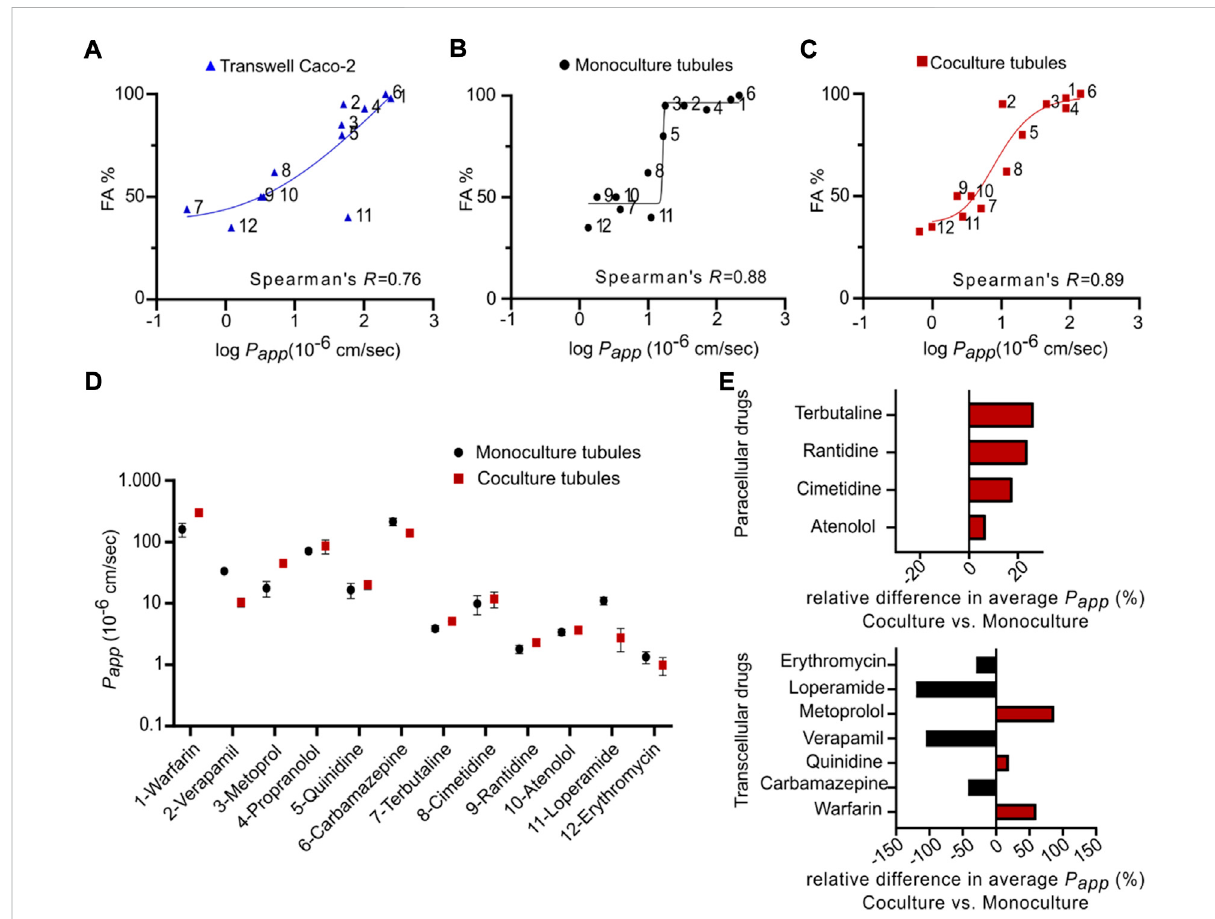
FIGURE 5 Correlationbetweenfractionsabsorbedinhumanandapparentpermeabilitycoef fi cientoftwelvemodeldrugsinmono-andcoculturetubules as well as standard Transwells. (A – C) The FA for each drug plotted against the average log Papp obtained from (A) Transwell (blue) (B) monoculture tubules (black) and (C) coculture tubules (red). All fi ts represent non-linear regression analysis using a two-tailed non-parametric Spearman ’ s correlationfunction,generatingSpearman ’ scoef fi cients( R ).Compounds1 – 12arelistedinSupplementaryTableS4. (D) Theaverage P app found foreitherthemonoculture(black)orthecoculture(red)tubulesplottedforeachindividual drugtested. (E) Therelativedifferenceoftheaverage P app for paracellular transporteddrugs (top) and transcellular transported drugs (bottom). Error bars represent theSEM for each drug transportmeasured for at least three biological replicates ( n =